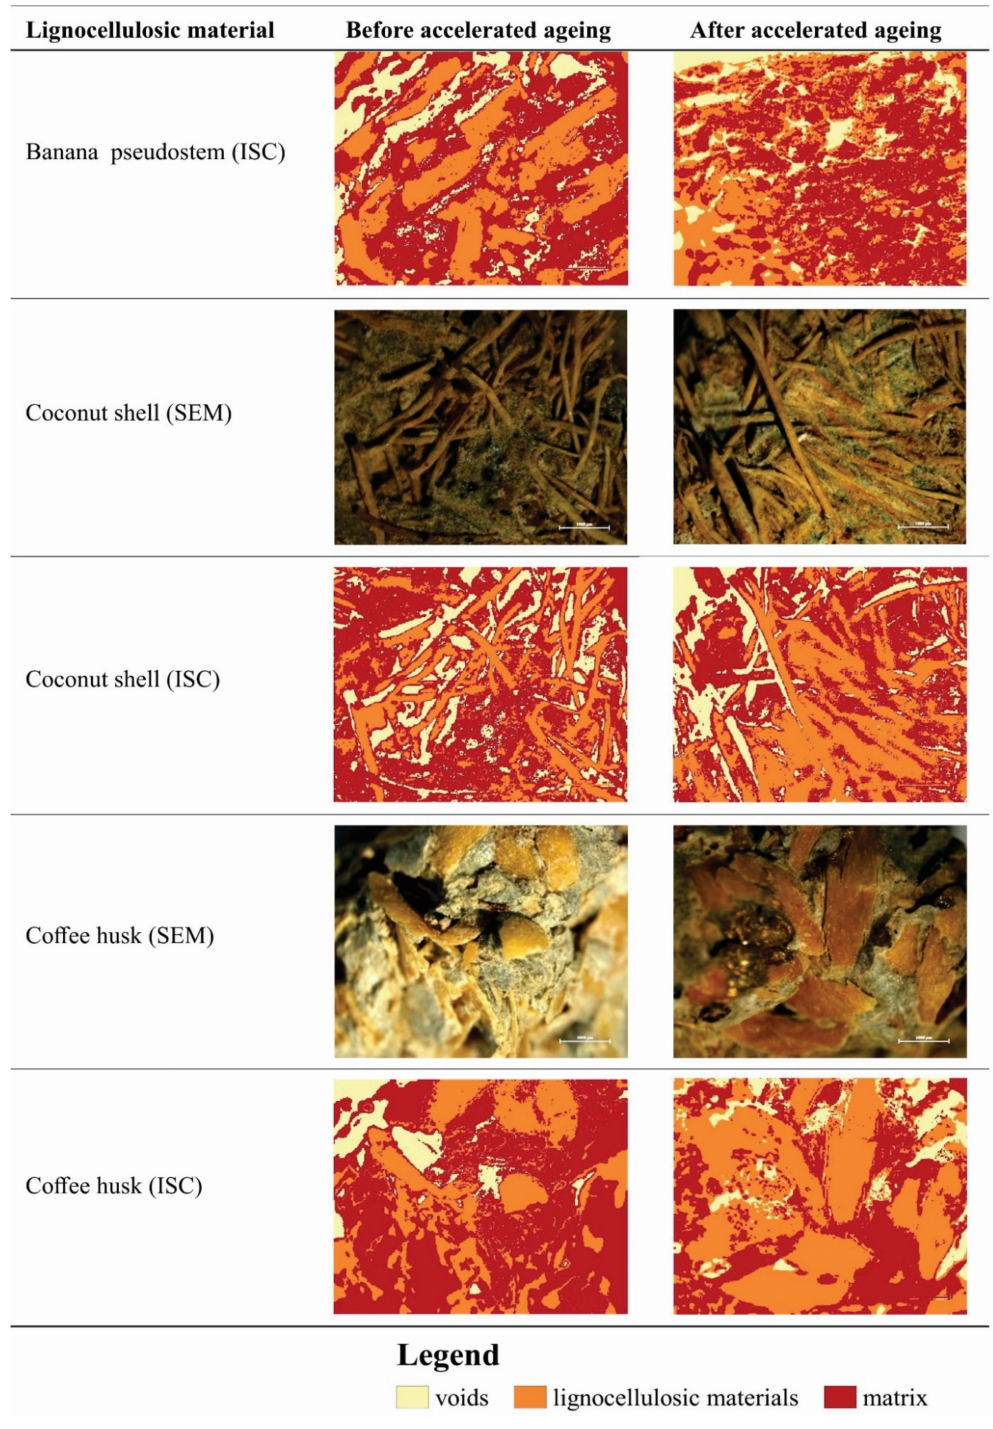
Figure 3. Scanning electron microscopy (SEM) images and image supervised classification (ISC) of the evaluated lignocellulosic materials before and after the accelerated ageing